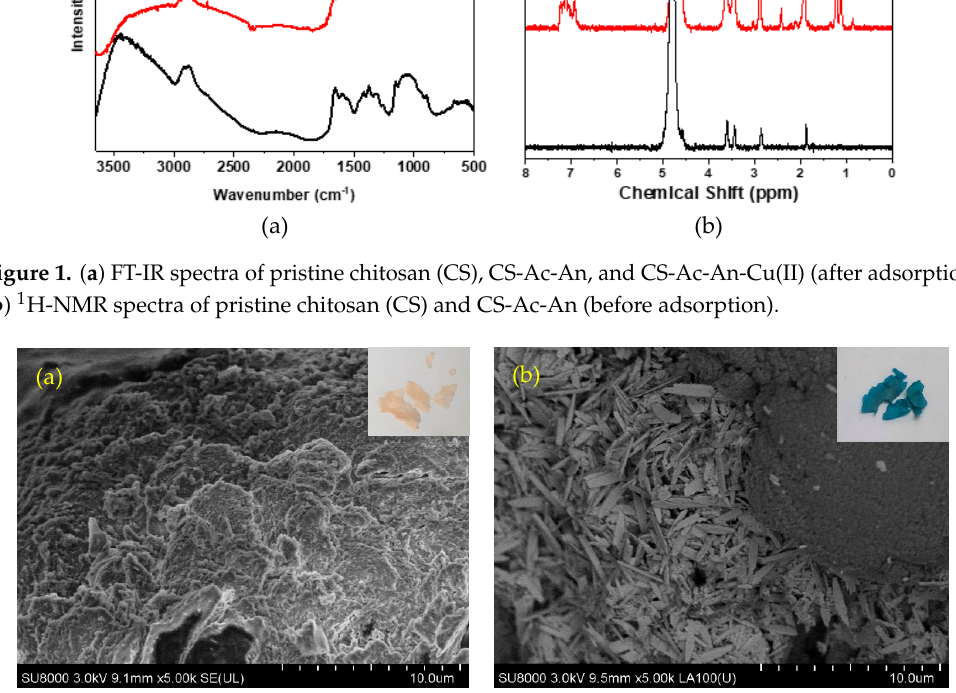
Figure 2. SEM images: ( a ) Secondary electron image of CS ‐ Ac ‐ An (before adsorption). ( b ) Backscattered electron image of CS ‐ Ac ‐ An ‐ Cu(II) with needle ‐ shaped copper sulfate on the surface of the adsorbent (concentration of Cu(II) solution: 100 mg L − 1 ). Insets: images that illustrate the off ‐ white color of adsorbent ((a) before adsorption) and the deep blue color of adsorbent ((b) after Cu(II) adsorption).